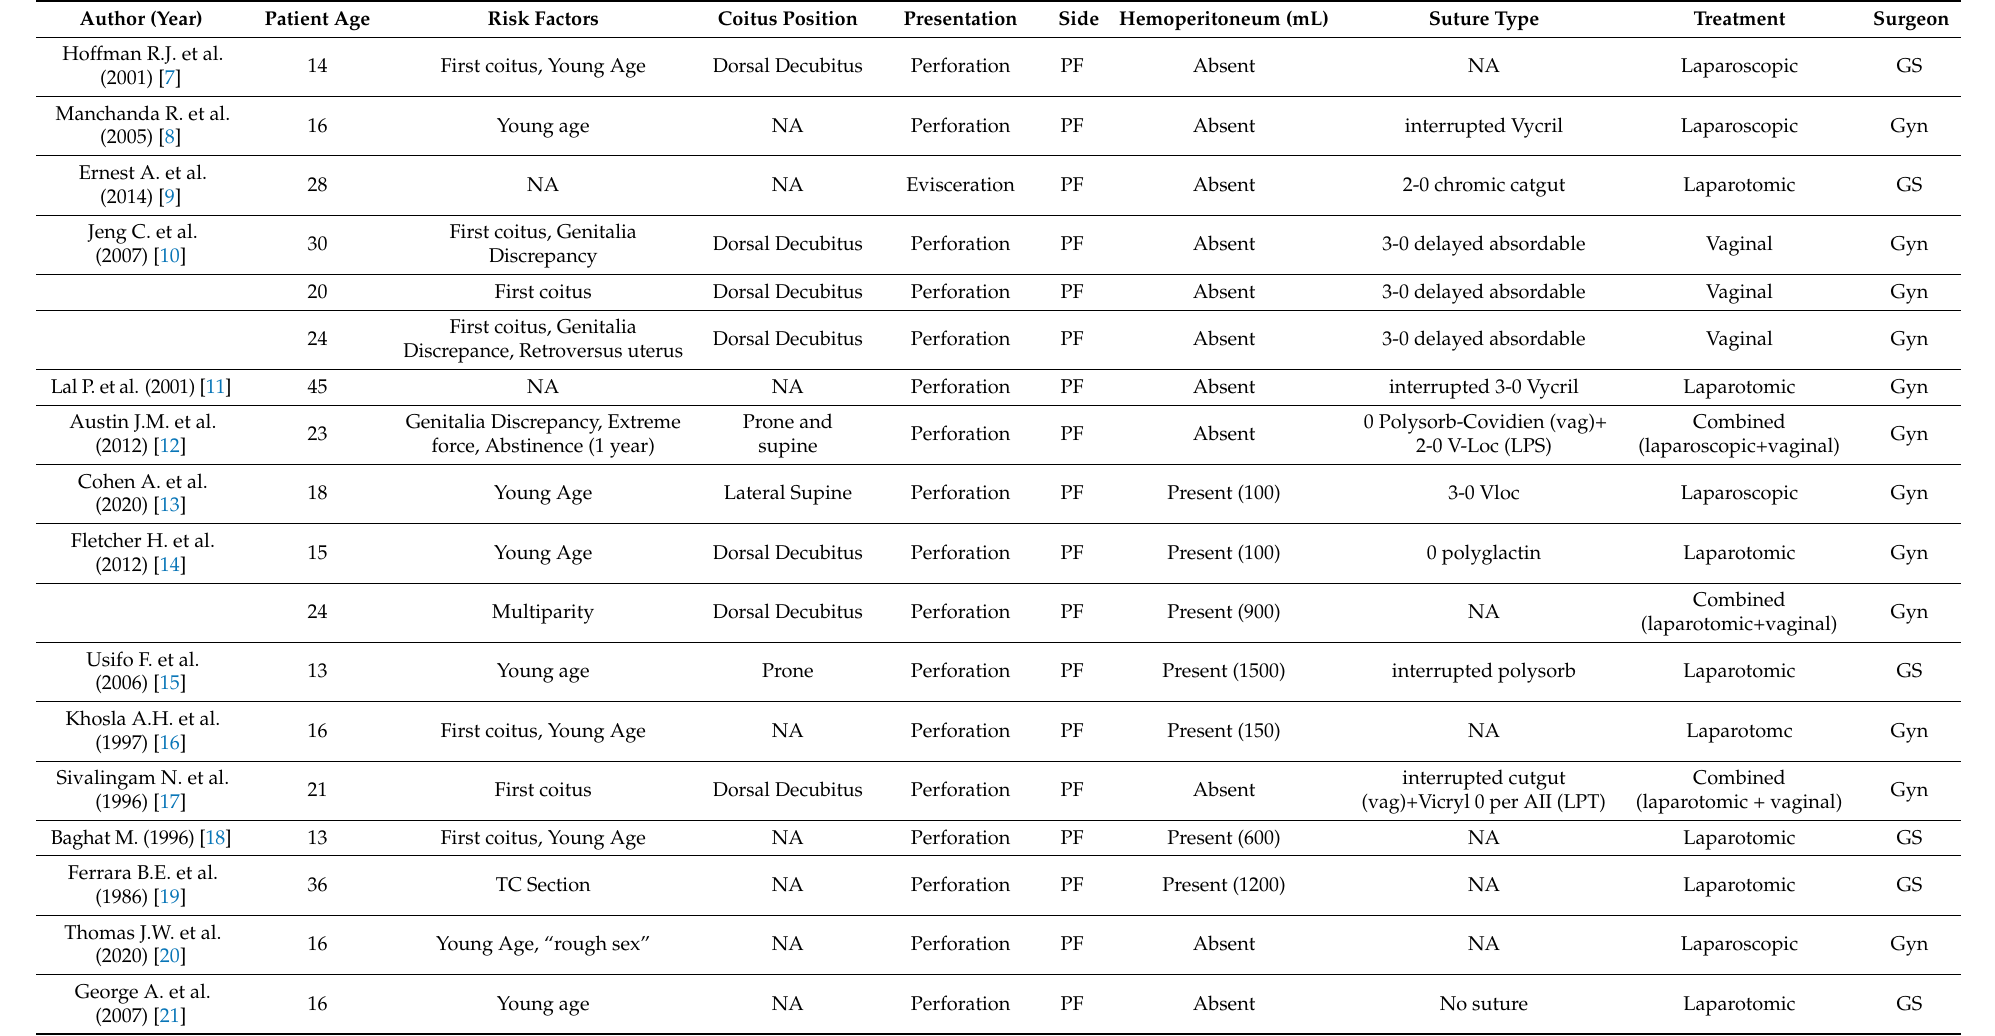
Table 1. Review of the literature Legends: GS—General Surgeon; Gyn—Gynecologist; NA—Not Applicable; PF—Posterior